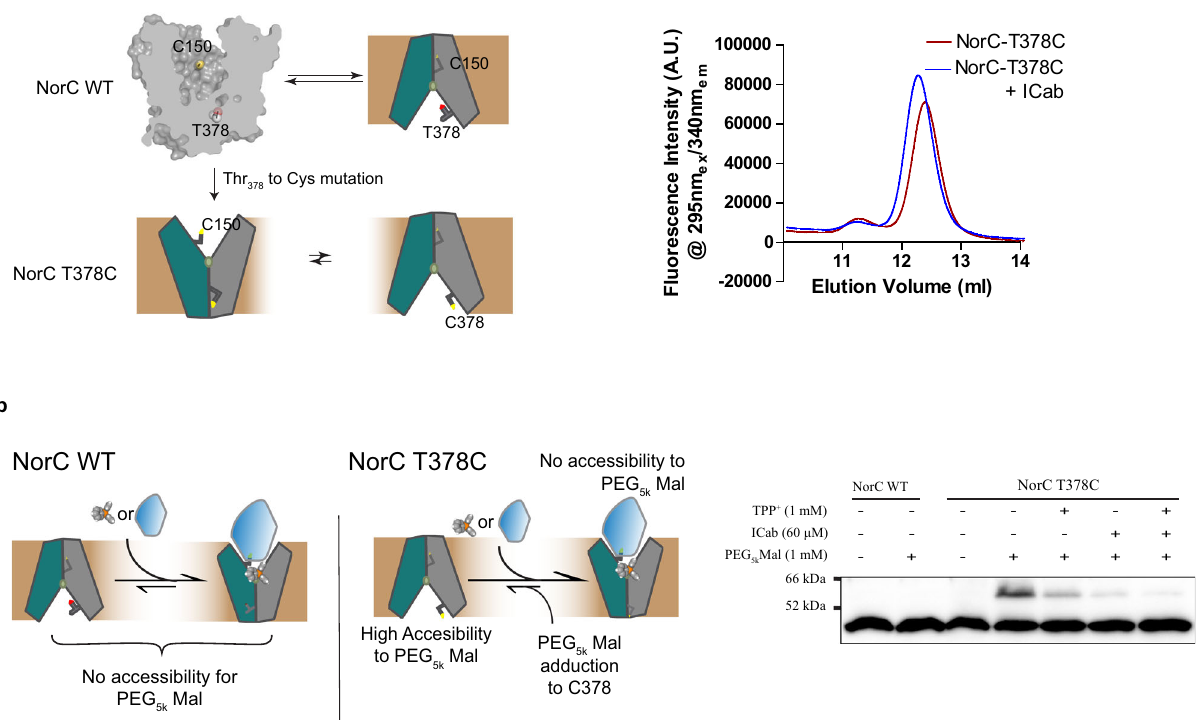
Fig. 5 Characterizing NorC conformational shifts in response to ICab and TPP + binding in E. coli membranes. a Schematic showing the accessibility of C150 and T378 of NorC in different conformations in native membranes. FSEC pro fi le with detergent puri fi ed NorC T378C incubated with ICab shows that the mutation does not alter NorC ’ s ability to interact with ICab. b Methoxypolyethylene glycol maleimide (or PEG5k Mal; avg mol wt = 5 kDa) accessibility assay in NorC ’ s vestibule in E. coli membranes. PEG5k Mal does not react with NorC WT in native membranes or in detergent puri fi ed form, while it readily interacts with NorC T378C, as seen in the western blot (probed with Anti-Histag antibody), but the reactivity decreases in presence of excess ICab, TPP + or both. n = 8 for independent replicates. Source data are provided in the source data fi